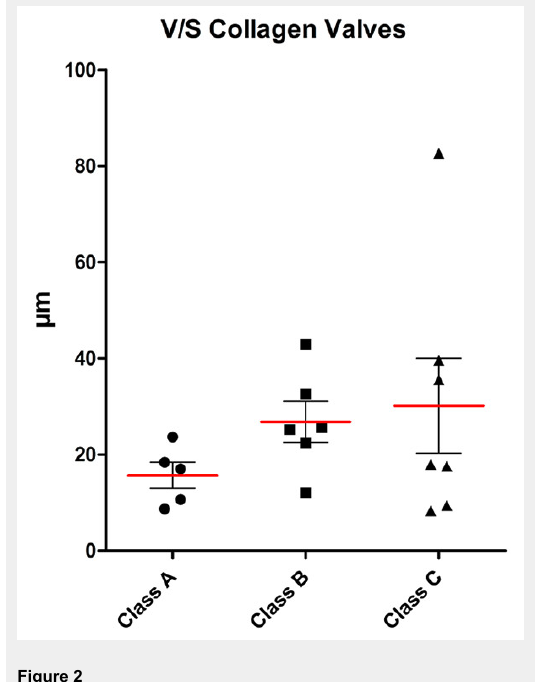
Volume-to-surface ratio of the collagen content of valves for the three classes (mean (red line), standard deviation and individual values).